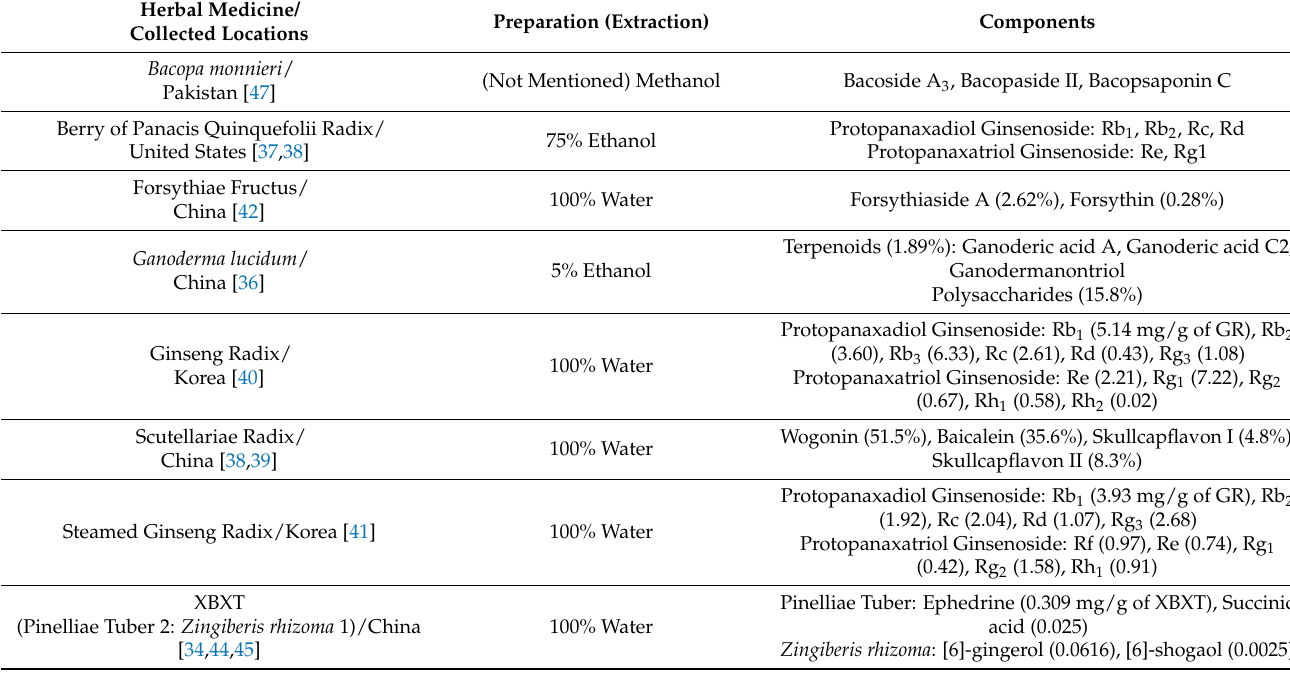
Table 2. Identified and Quantified Sub-Components of Herbal Medicines Used in